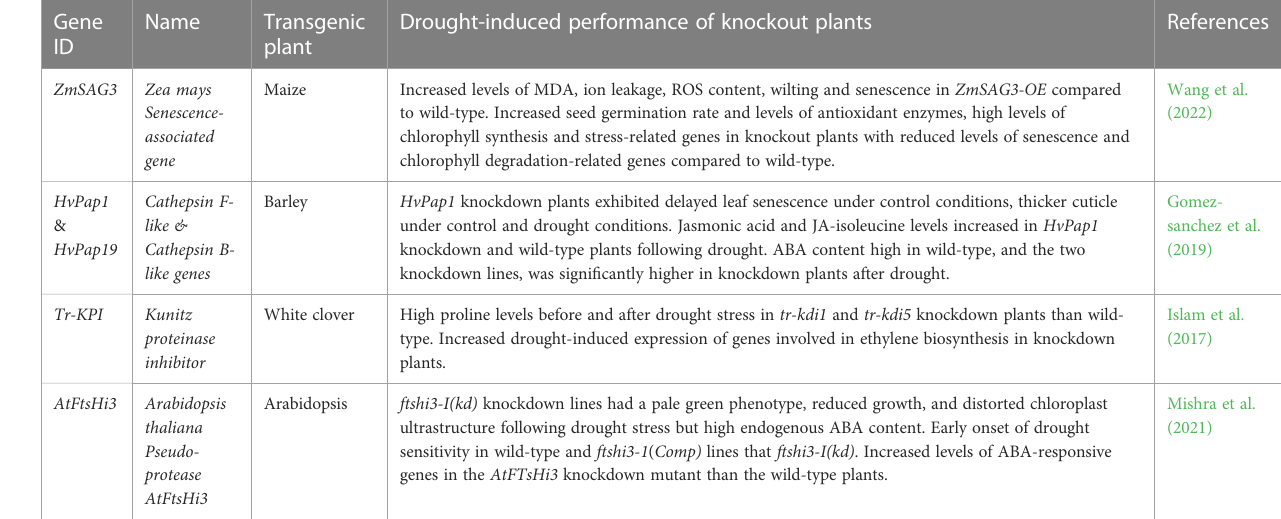
TABLE 6 List of transgenic knockout/down studies illustrating the roles of protease and protease inhibitors in plants under drought stress. Gene ID